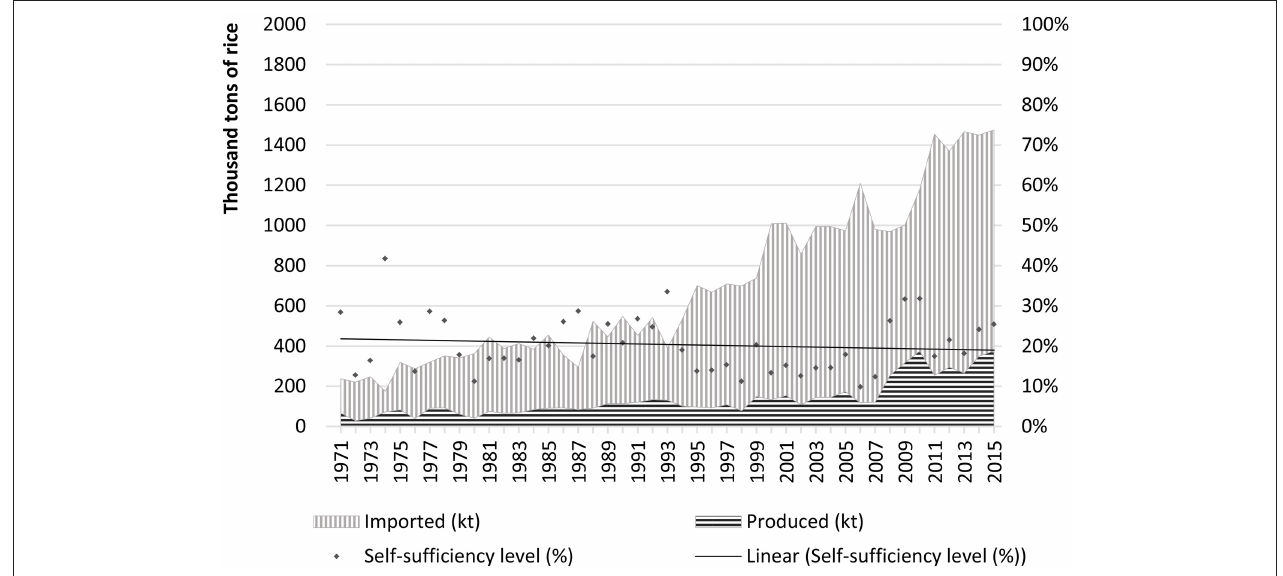
FIGURE 1 | Growth of rice production in Senegal and rice imports from abroad between 1970 and 2015. Data source: IRRI – International Rice Research Institute (2015), using USDA